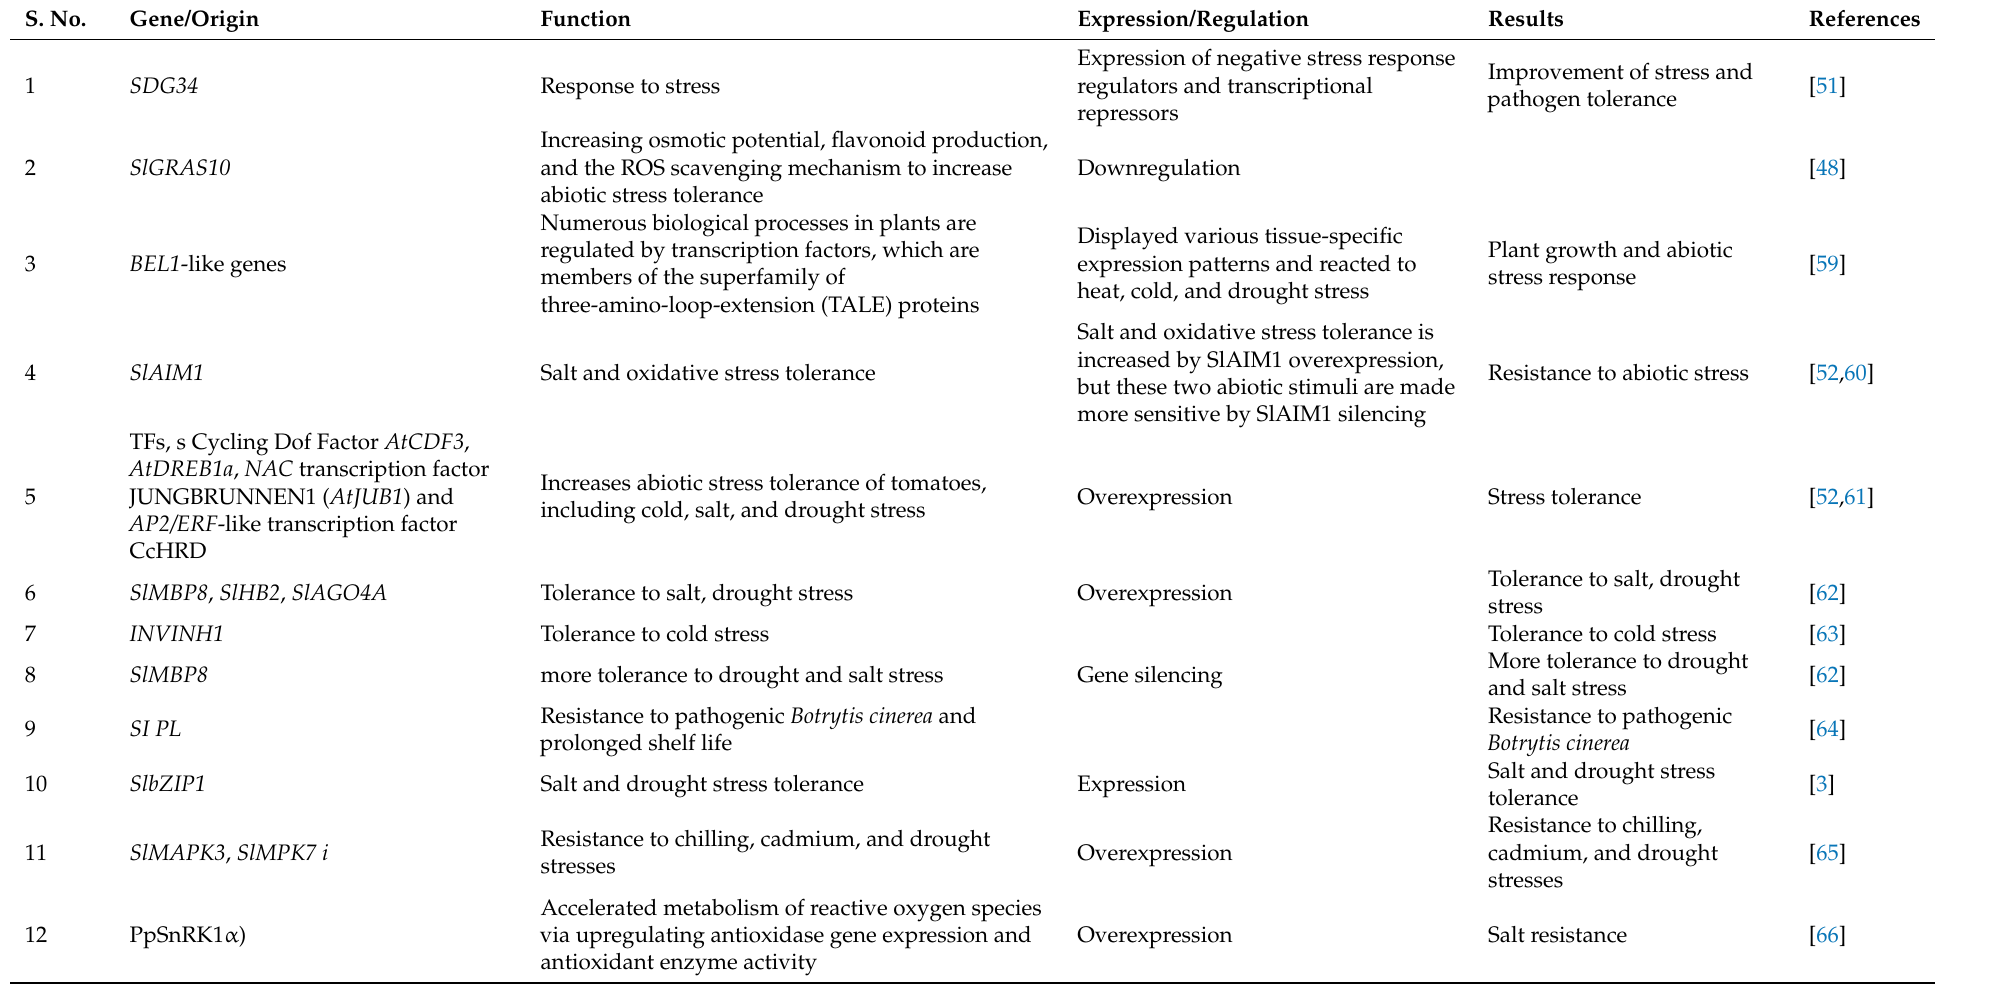
Table 1. Genomics to combat abiotic stress tolerance in